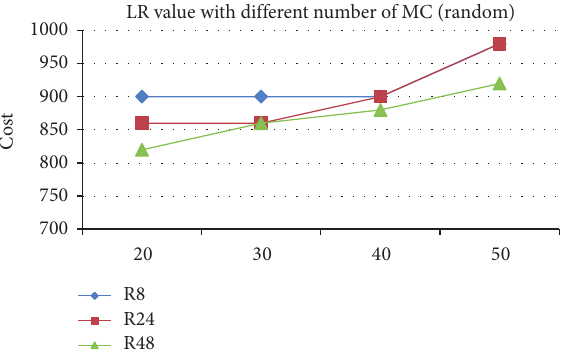
Figure 11: Deployment cost with different number of RS (1BS, random, 3.2 km). Figure 12: Deployment cost with different number of MS (1BS, random,